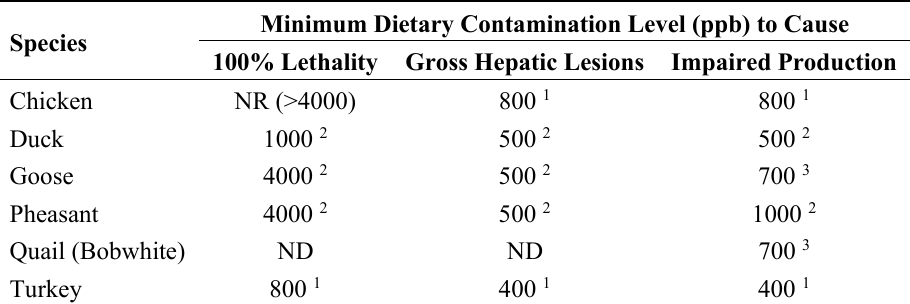
Table 2. Minimum AFB 1 concentrations with major effects in